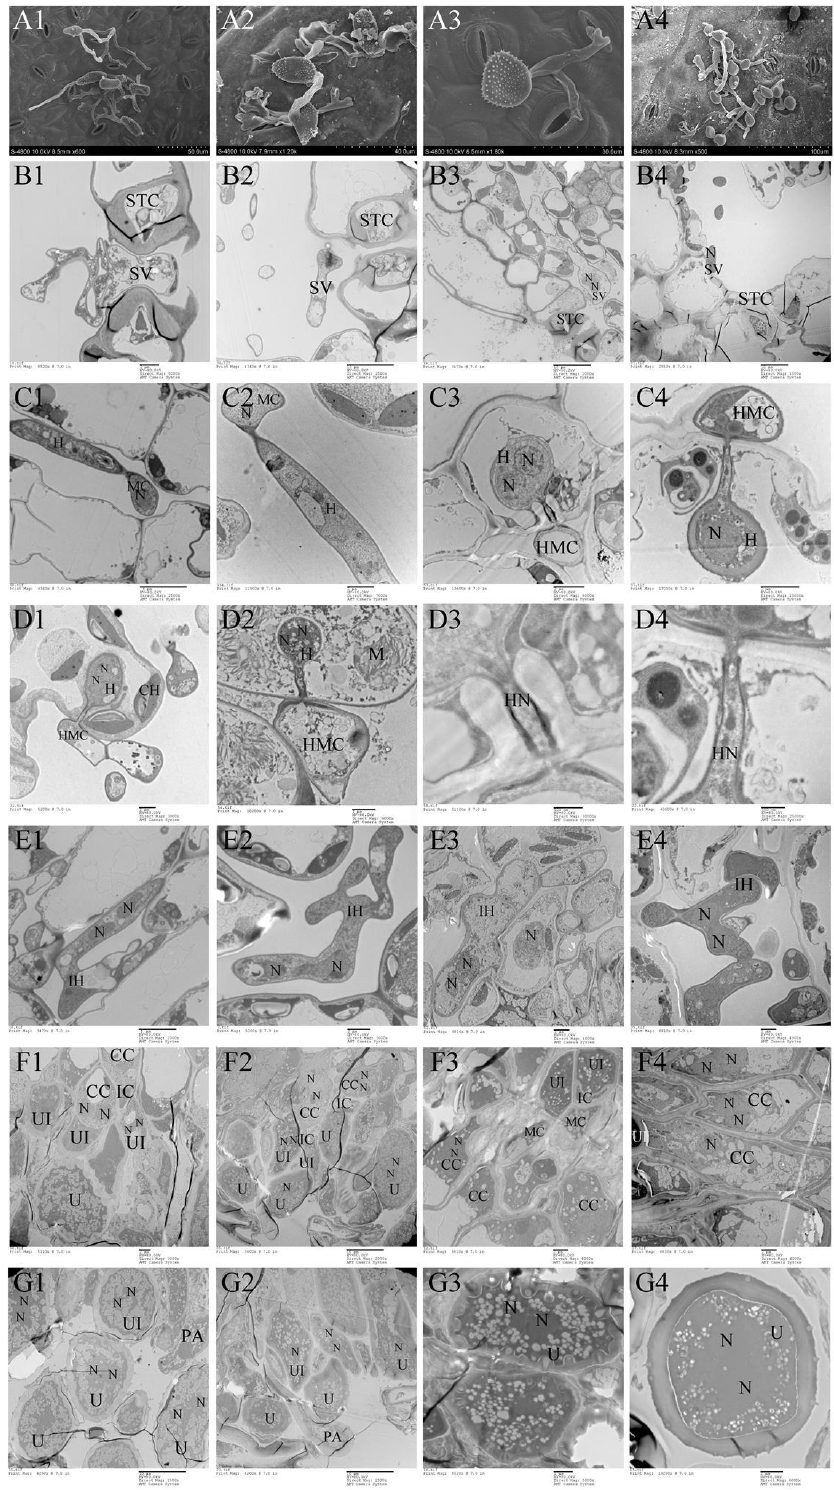
Figure 5. Ontogeny of uredia stage. ( A1 – G1 ), Mlp ; ( A2 – G2 ), Mmed ; ( A3 – G3 ), Mmag ; ( A4 – G4 ), Mpr ; Appressorium (A); stomatal cell (STC); substomatal vesicle (SV); nuclei (N), mother cell (MC); hypha (H); intercellular hypha (IH); interval cell (IC); haustorium mother cell (HMC); haustorium (H); chloroplast (CH); mitochondria (M); conidiogenous cell (CC); urediniospore initial (UI); urediniospore (U); interval ce;ll (IC); paraphysis